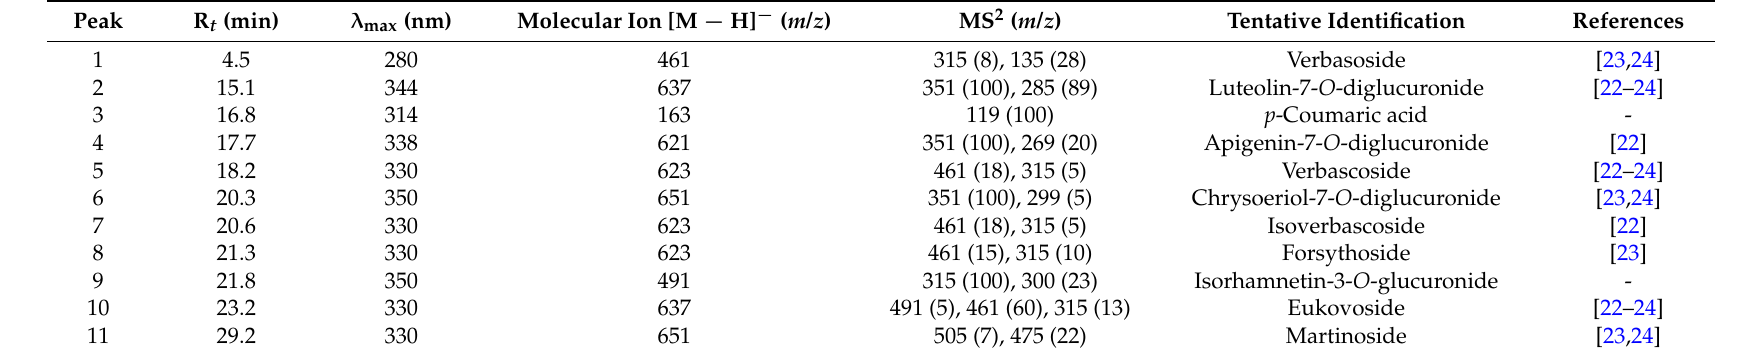
Table 1. Retention time (R t ), wavelengths of maximum absorption in the visible region ( λ max ), mass spectral data (MS and MS 2 ) and tentative identification of phenolic compounds in Aloysia citrodora